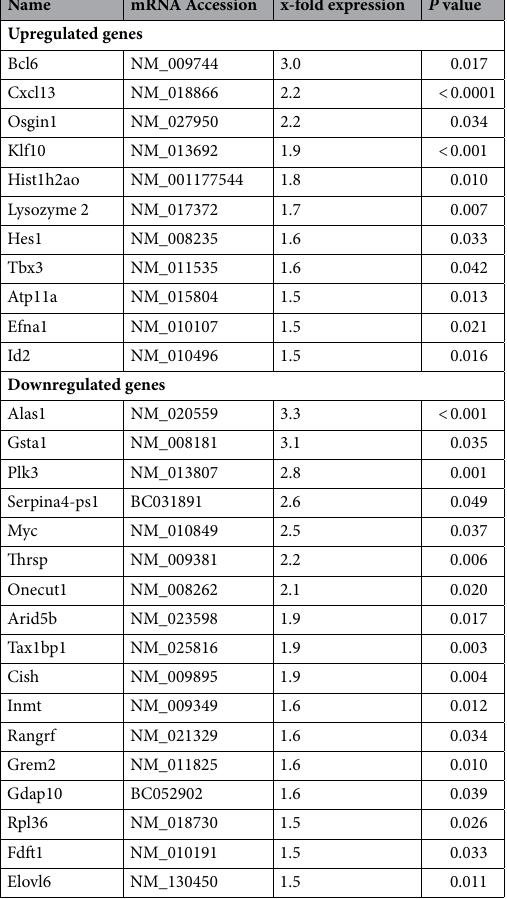
Table 1. Differentially expressed mRNA in Tax1BP1 −/−